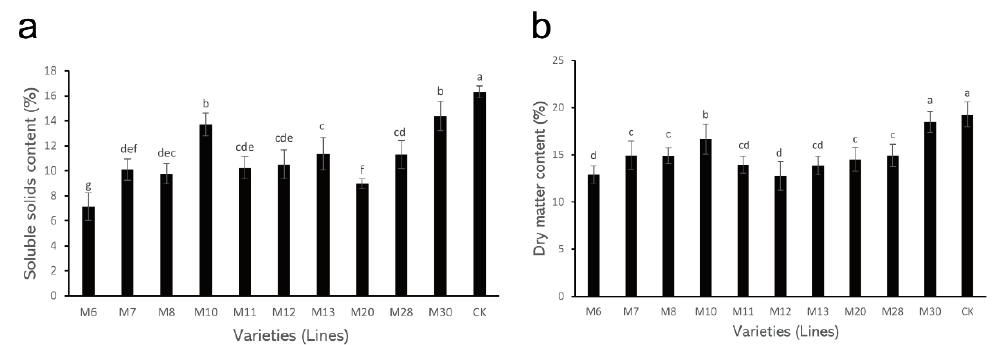
Figure 1. Changes in soluble solid content ( a ) and dry matter content ( b ) in wild A. eriantha varieties (lines) at the ripening stage. The different letters in each figure indicate significant differences ( p < 0.05), and the same letters indicate no significant difference ( p > 0.05).